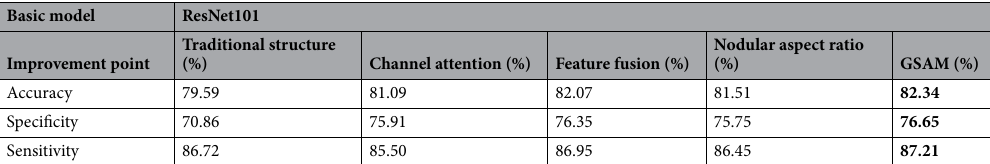
Table 5. Comparison of improvement points based on ResNet101. Significant values are in